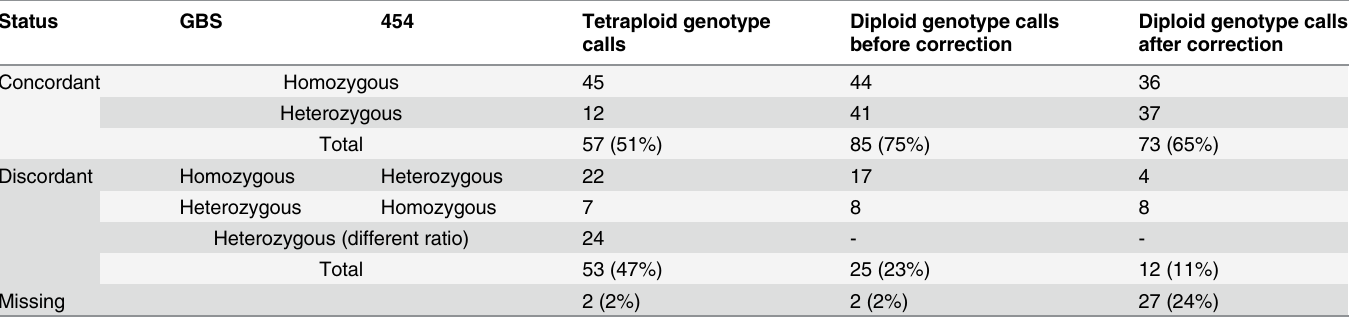
Table 6. Observed consistency of genotype calls obtained with GBS and 454 sequencing of 14 SNP loci in eight plant samples.